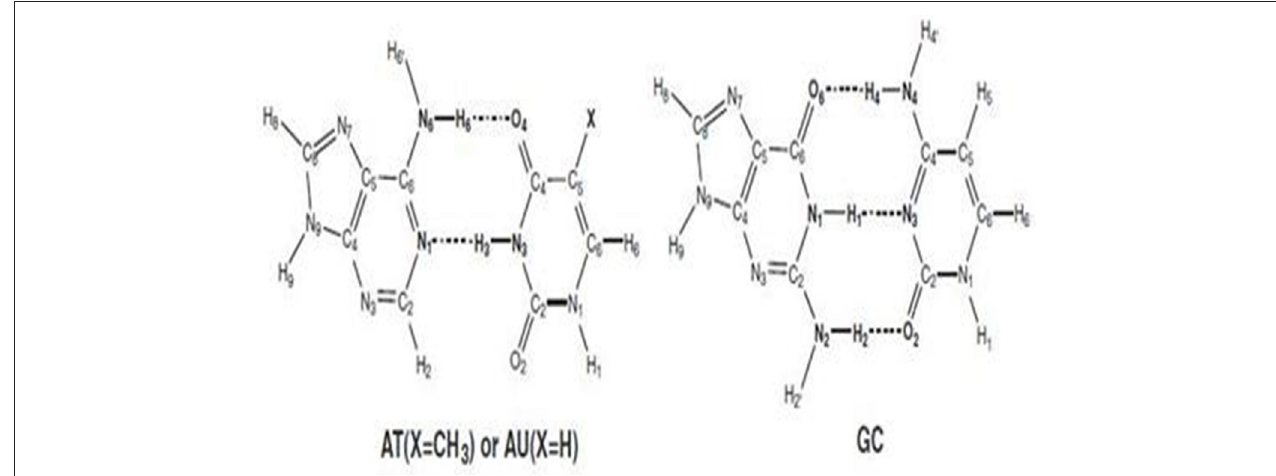
FIGURE 1 | The Schematic representation of DNA and RNA base